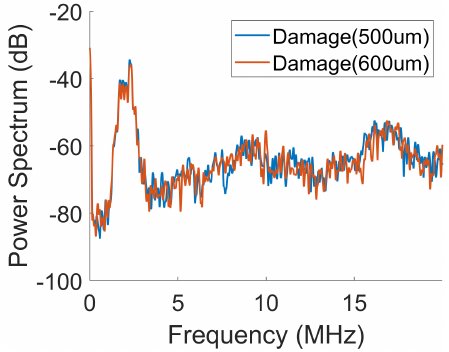
Figure 5. Power spectra vs. normalized frequency for data of damage (500 µ m) and damage (600 µ m). Here, the root mean square of the difference between the two spectra is